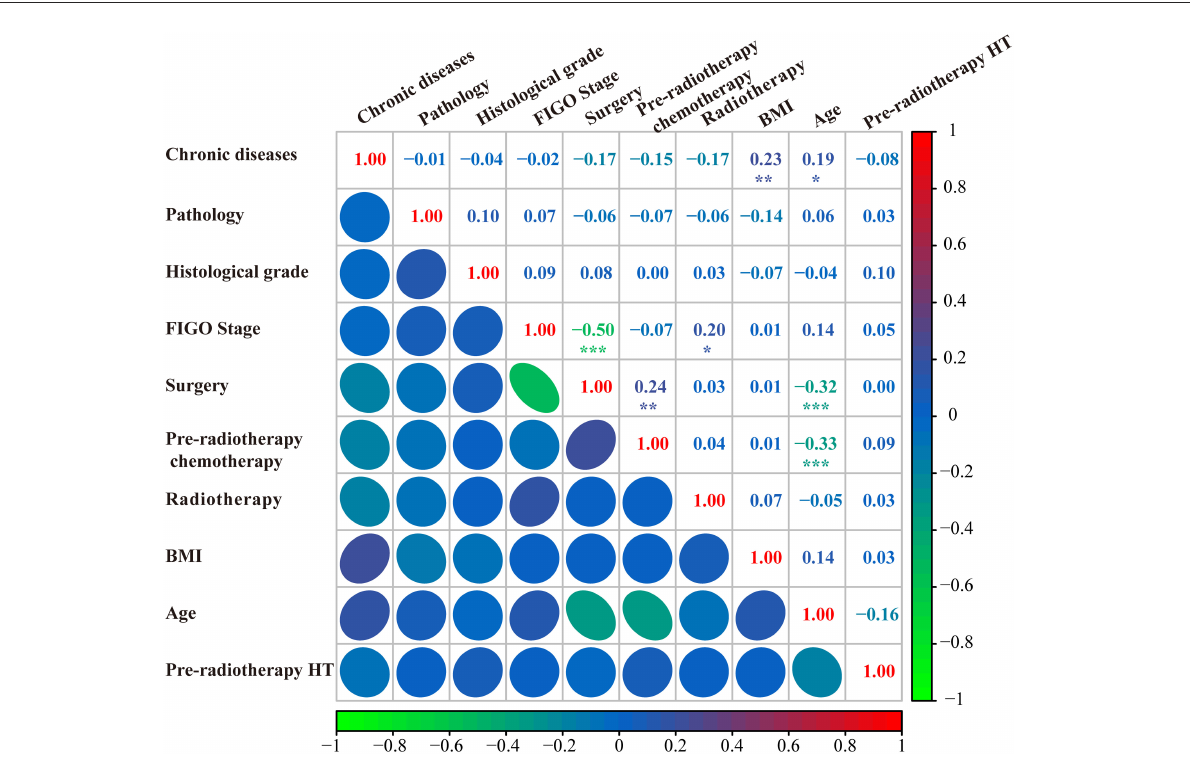
FIGURE2 Correlation analysis of all predictors. FIGO, international federation of gynecology and obstetrics; BMI, body mass index; HT, hematological toxicity.